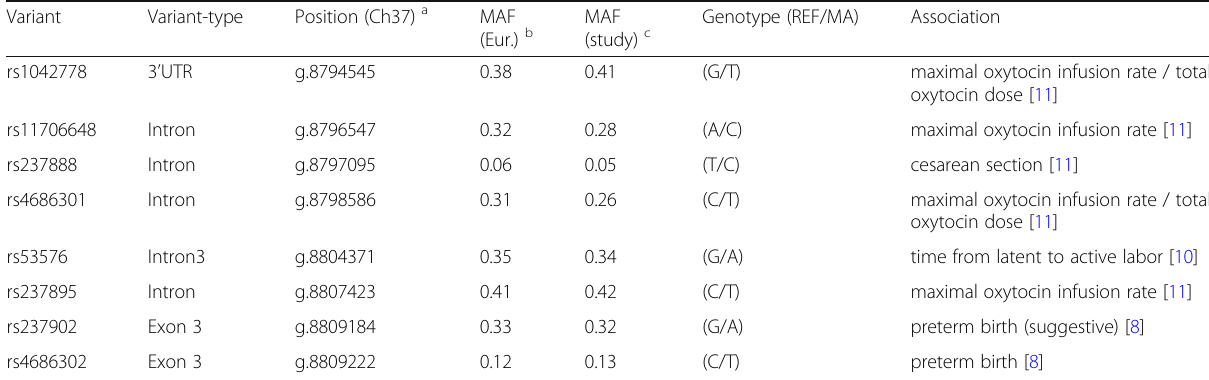
Table 2 Overview of the single-nucleotide sequence variants considered in the present work Variant